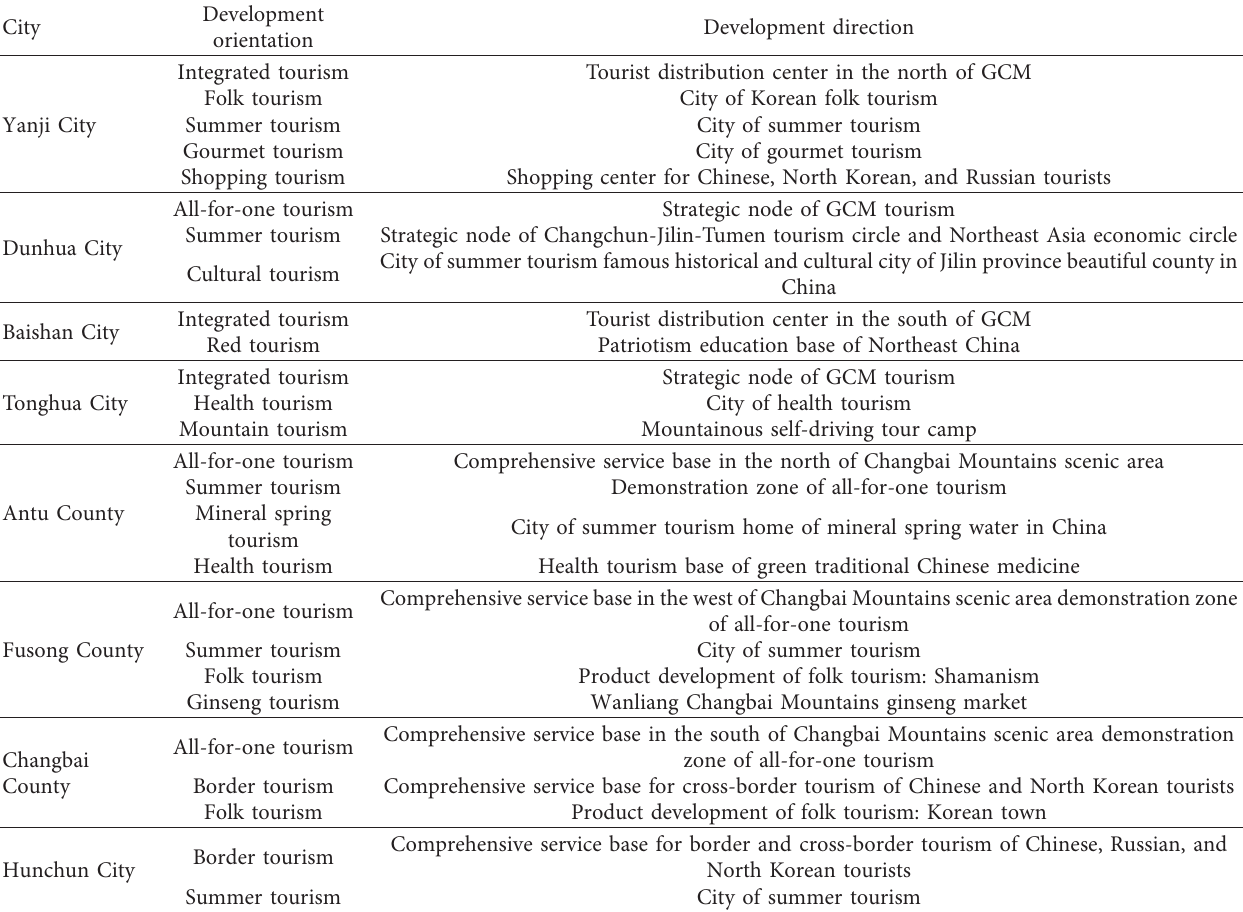
Table 6: Tourism development orientations of core region of CGM tourist